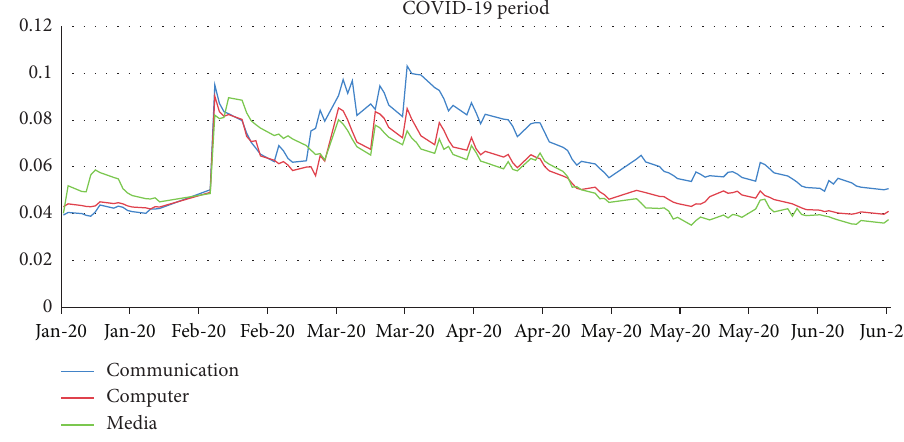
Figure 15: ∆ CoVaR of the communications, computer, and media sectors in the COVID-19